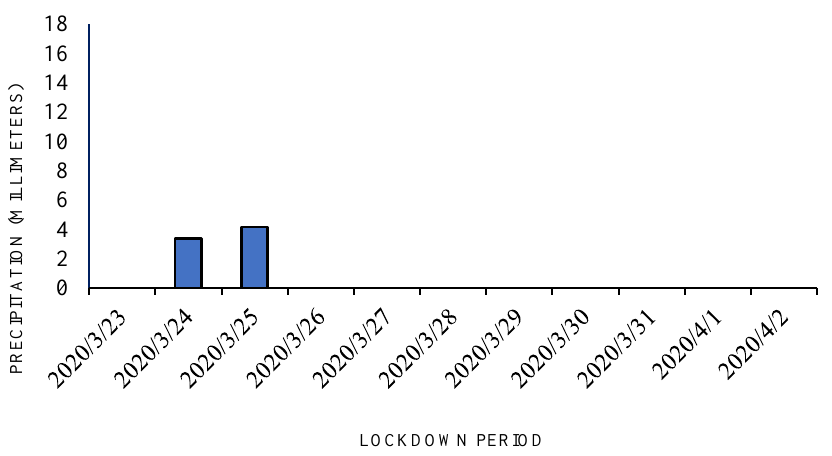
Figure 2. Rainfall in the pre-lockdown period.